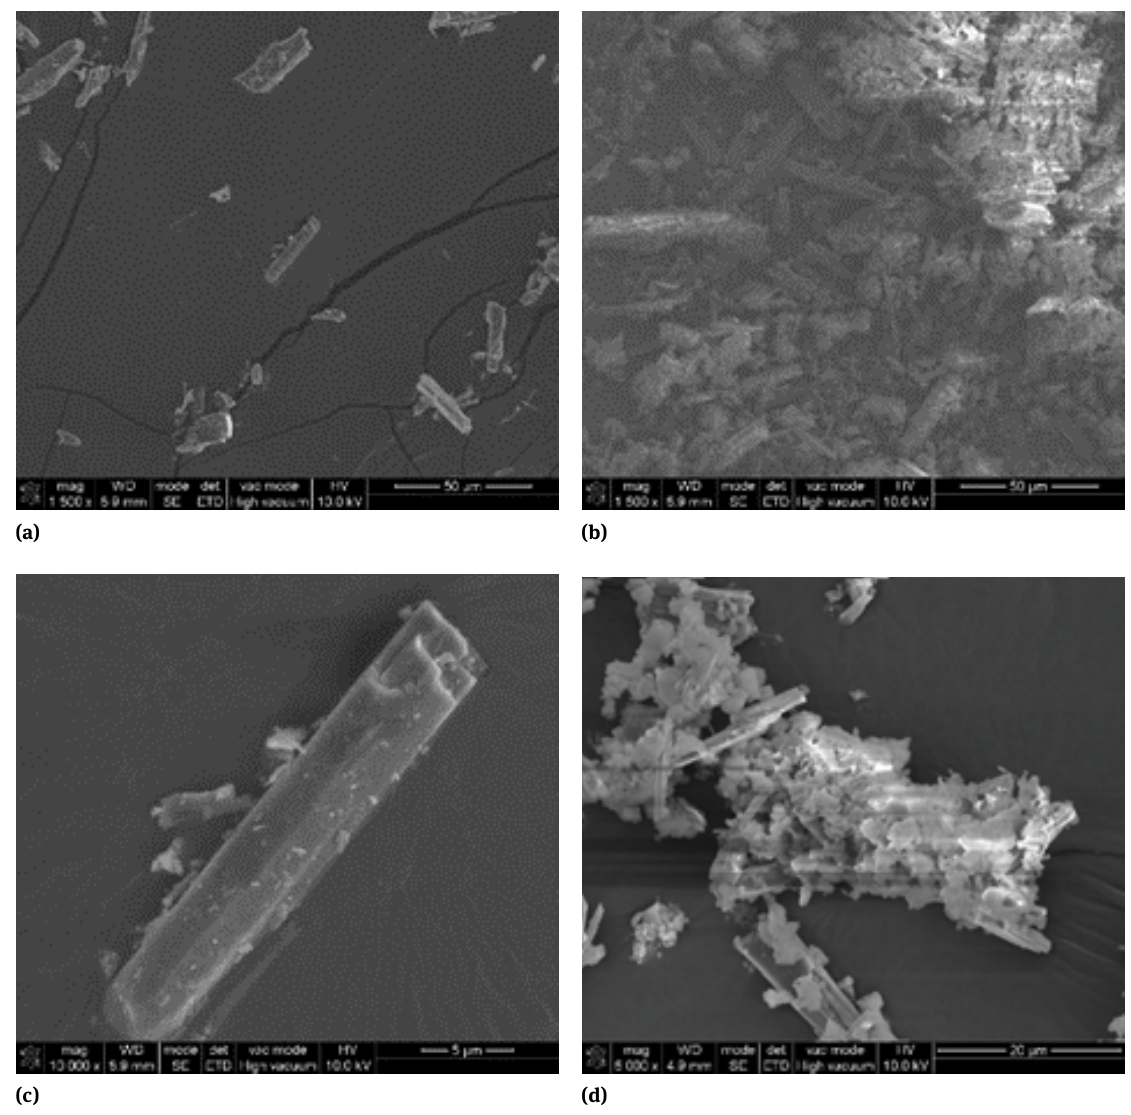
Figure 11: The SEM images of the wollastonite before and after the compound. a)0% (Magnify 1500 times); b) 12% (Magnify 1500 times); c) 0% (Magnify 10000 times); d) 12% (Magnify 10000 times)